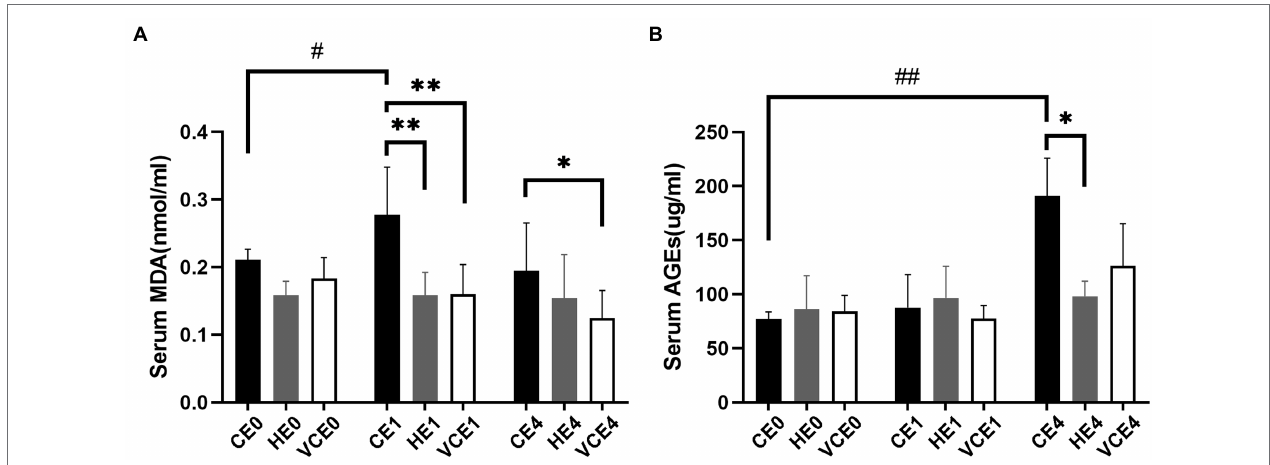
FIGURE 8 | Lipid peroxidation products in serum, as markers of oxidative stress, were determined by detection of MDA (A) . The serum AGEs by ELISA indicates the extent of protein oxidation damage (B) . C, blank control; H, inhalation of hydrogen gas; VC, vitamin C supplementation; E0, baseline; E1, immediately after exercise; and E4, 4 h after exercise. n = 8 per group. * p < 0.05, ** p < 0.01; # p < 0.05; ## p <